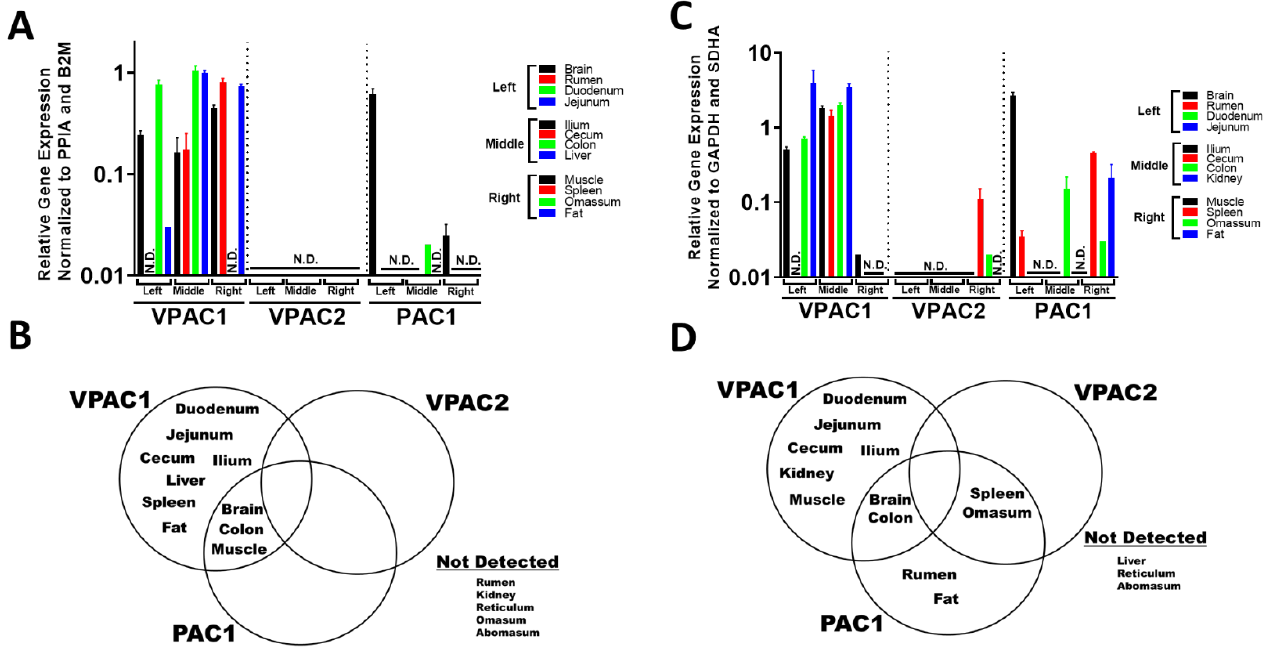
Figure 3. Differential relative mRNA profiles for VIP and PACAP receptors. Data is presented in bar graph form with technical duplicate means +/ − SD of pooled cDNA ( n = 3 − 4) for indicated tissues measured in ( A ). wethers or ( C ) . ( C , D ). Venn diagrams representing tissue expression of VIP/PACAP receptors with overlap indicating identical expression profiles between ( B ). wethers and ( D ). steers. Table 2. Relative mRNA Expression Ranking in Ruminant Tissues. Relative expression rank: High — ++, Intermediate — +, Low —− /+, and not detected — ND.